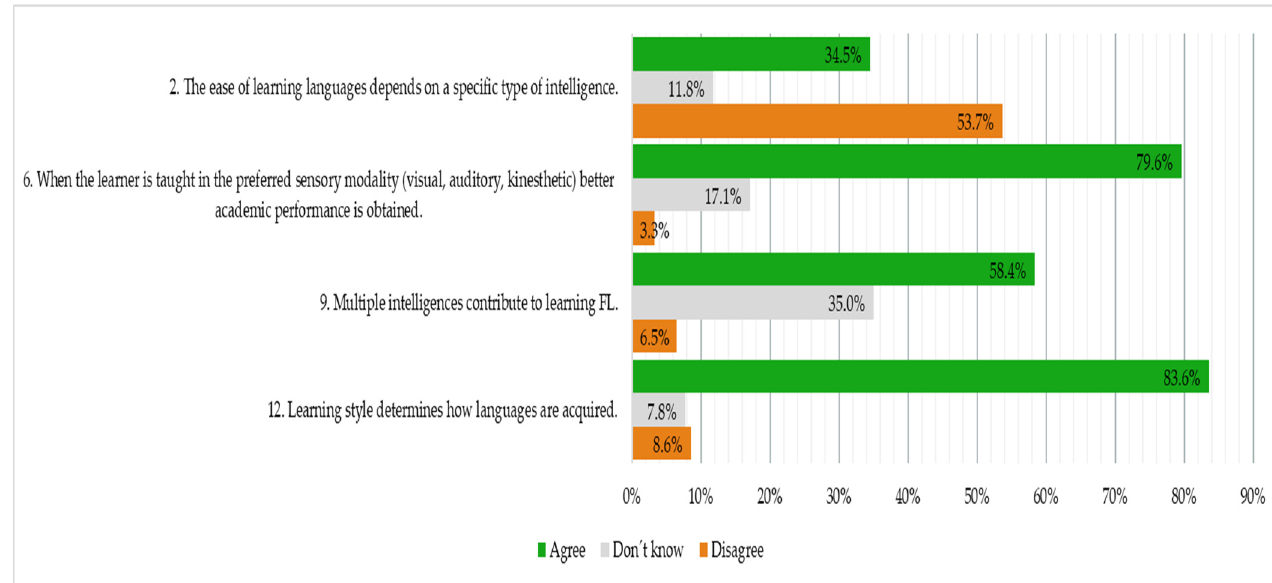
Figure 2. Frequency distribution of the 4 items that make up Dimension 2. Beliefs on multiple intelligences and learning styles.